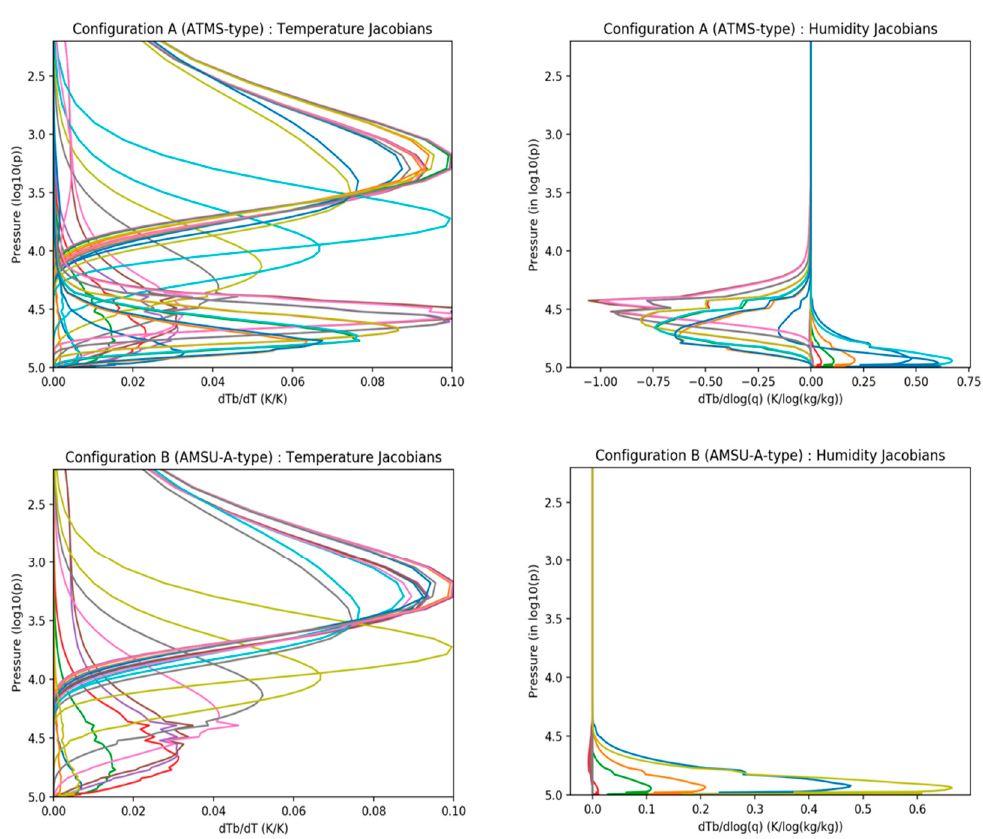
Figure 6. Simulated temperature and humidity Jacobians for two MW instrument configurations (A and B): Temperature and Humidity Jacobians for configuration A (ATMS-type) (shown in two figures in the top panel) and for configuration B (AMSU-A-type) (shown in side-by-side two figures in the bottom panel).